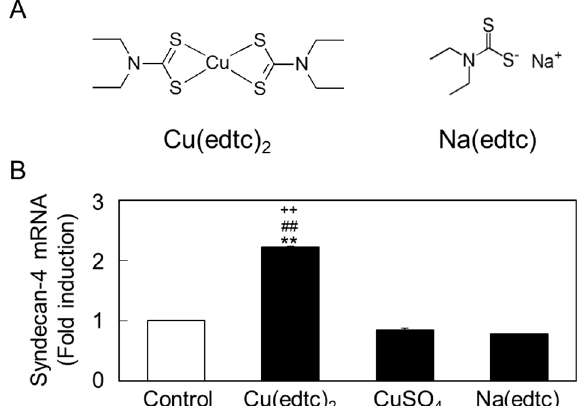
Figure 3. Comparison of the syndecan-4 mRNA induction by different structural components of Cu(edtc) 2 . ( A ) Structure of Cu(edtc) 2 and Na(edtc); ( B ) expression of syndecan-4 mRNA. The cells were incubated at 37 °C for 8 h in the presence of Cu(edtc) 2 (3 µM), CuSO 4 (3 µM), or Na(edtc) (6 µM). Syndecan-4 mRNA levels were then determined by RT-PCR. Values are means ± S.E. of four replicates. ** p < 0.01 vs. the corresponding control. ## p < 0.01 vs. CuSO4. ++ p < 0.01 vs. Na(edtc).